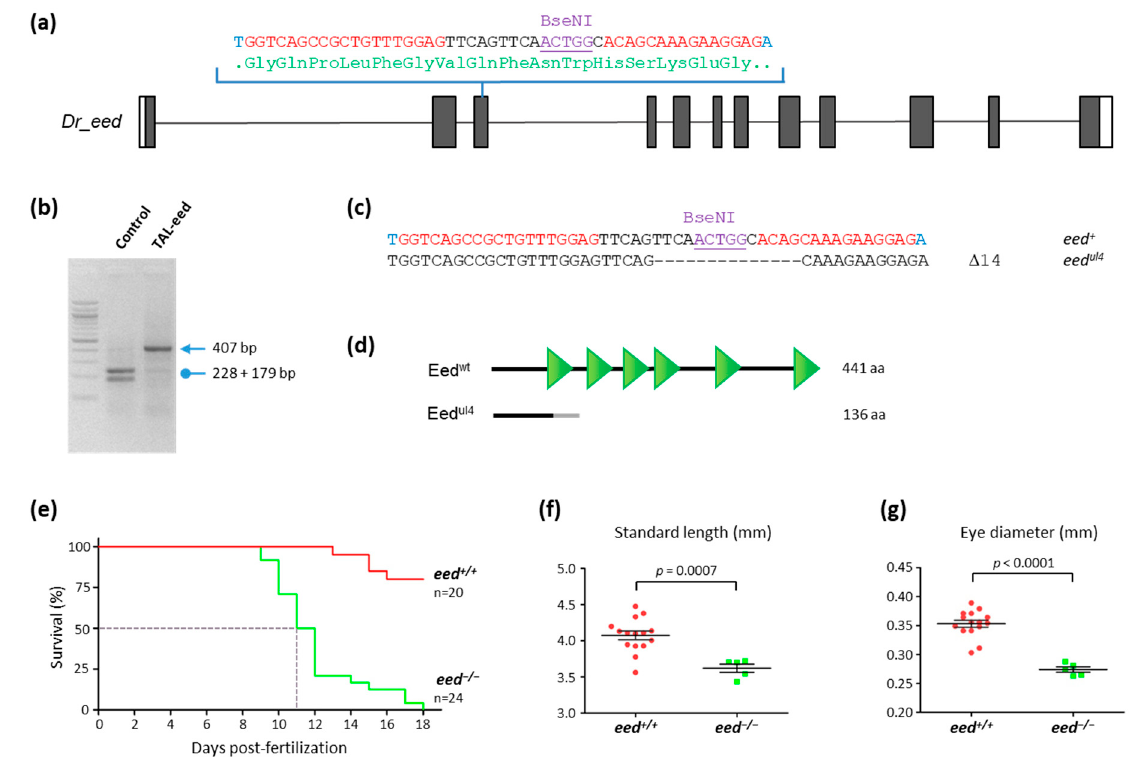
Figure 2. Loss of eed gene function leads to zebrafish death at around 10–12 dpf: ( a ) schematic representation of the genomic structure of the eed gene, with coding and untranslated sequences depicted as solid and open boxes, respectively. The sequence targeted by the TALEN in exon 3 is indicated with left and right TALEN binding sites shown in red, while the BseNI restriction sequence is underlined; ( b ) identification of mutant embryos using restriction fragment length polymorphism. Genomic DNA was prepared from an uninjected (Control) and an eed TALEN injected (TAL-eed) embryo, amplified by PCR and subjected to BseNI digestion. The TAL-eed injected embryo contains undigested material (arrow at 407 bp), indicating that the BseNI diagnostic restriction site has been disrupted; ( c ) sequence of the mutant allele compared to its wild-type counterpart. Dashes show deleted nucleotides. The mutated eed ul4 allele possesses a deletion of 14 nucleotides; ( d ) schematic representation of wild-type (Eed wt ) and predicted mutant (Eed ul4 ) proteins. The gray line in the predicted mutant protein corresponds to residues read out of frame prior to encountering a premature STOP codon. The green triangles in the wild-type protein show the WD40 domains; ( e ) Kaplan–Meier survival curves over 18 days for eed +/+ (red curve) and eed ‐ / ‐ (green curve) siblings from a cross between heterozygous eed +/ − fish. The number of fish considered is indicated; ( f ) measurement of the total length of eed +/+ (red) and eed − / − (green) siblings from a cross between heterozygous eed +/ ‐ fish at 11 dpf. Statistical significance was assessed using a t ‐ test; ( g ) measurement of the eye diameter of eed +/+ (red) and eed ‐ / ‐ (green) siblings from a cross between heterozygous eed +/ ‐ fish at 11 dpf. Statistical significance was assessed using a Student t ‐ test.